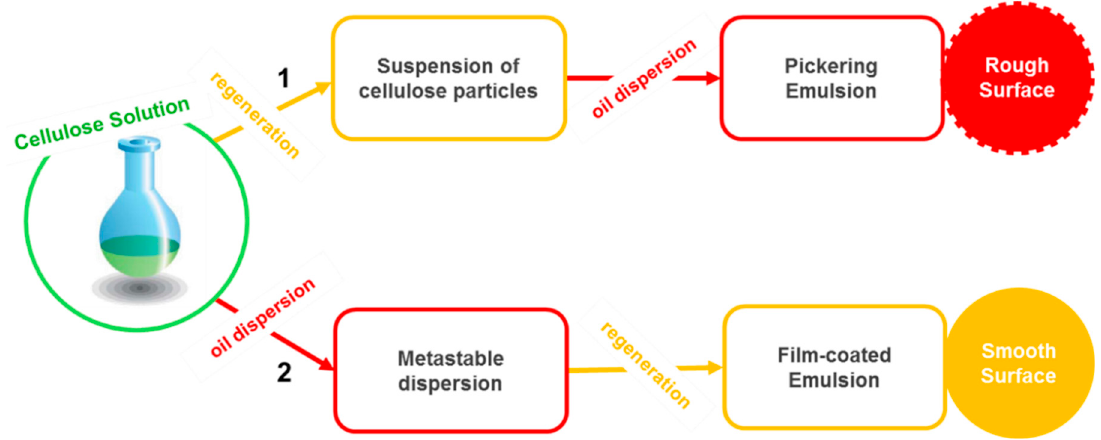
Figure 3. Two established approaches of preparing emulsions stabilized by cellulose. Adapted from [91].